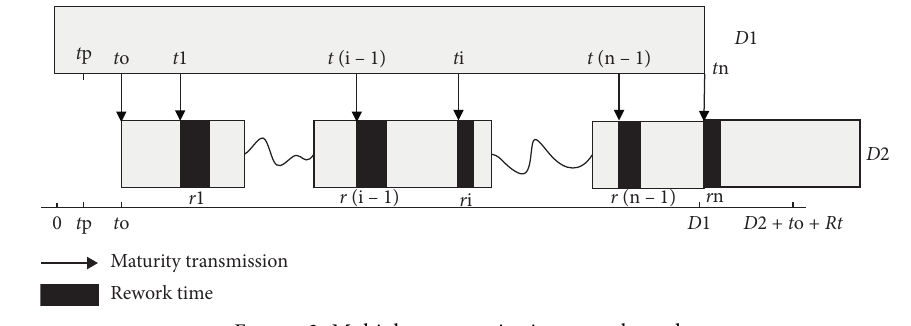
Figure 2: Multiple communication-rework mode.